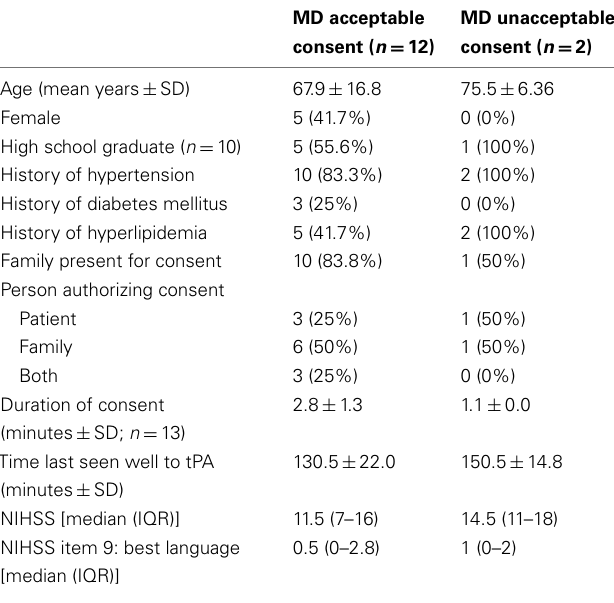
Table 2 | Patient characteristics for acceptable vs.